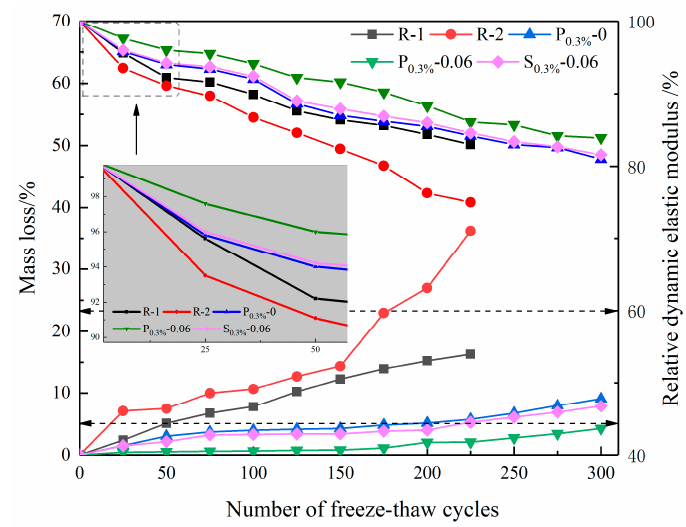
Figure 9. Mass loss and relative dynamic elastic modulus of cement mortar with different adding methods of SAP in freeze-thaw cycles.